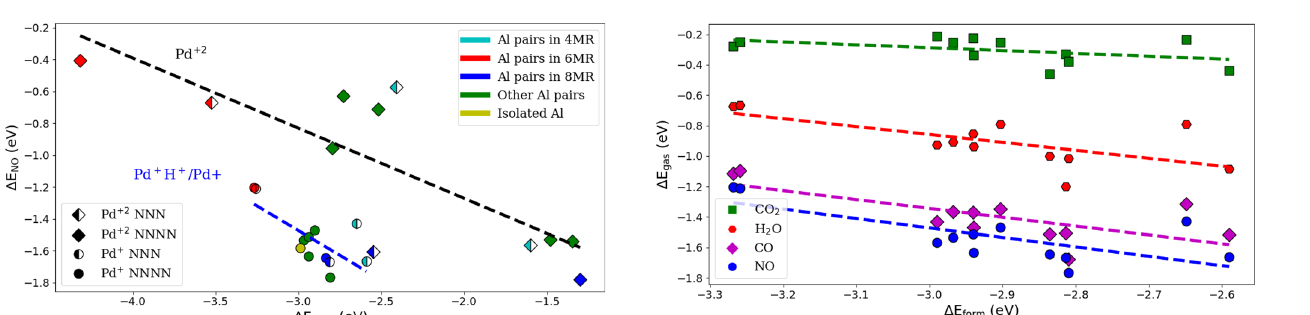
Fig. 8 NO Binding energy versus Pd formation energy on CHA. The color coding refers to the type of Al in the n -MR. The marker shapes ( ♢ and ∘ ) represent Pd + 2 and Pd + /Pd + H + , respectively. Filled markers are used for Al pairs in NNNN con fi guration and half- fi lled markers are for isolated Al or Al in NNN con fi gurations. For visual clarity, linear lines based on fi tting the data are added (black and blue for Pd + 2 and Pd + /Pd + H + , respectively).